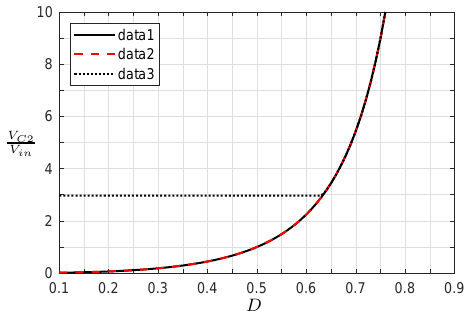
Figure 8. Voltage conversion gain (data 1: voltage converter appl; data 2: PV appl, resistive load; data 3: PV appl, clamped